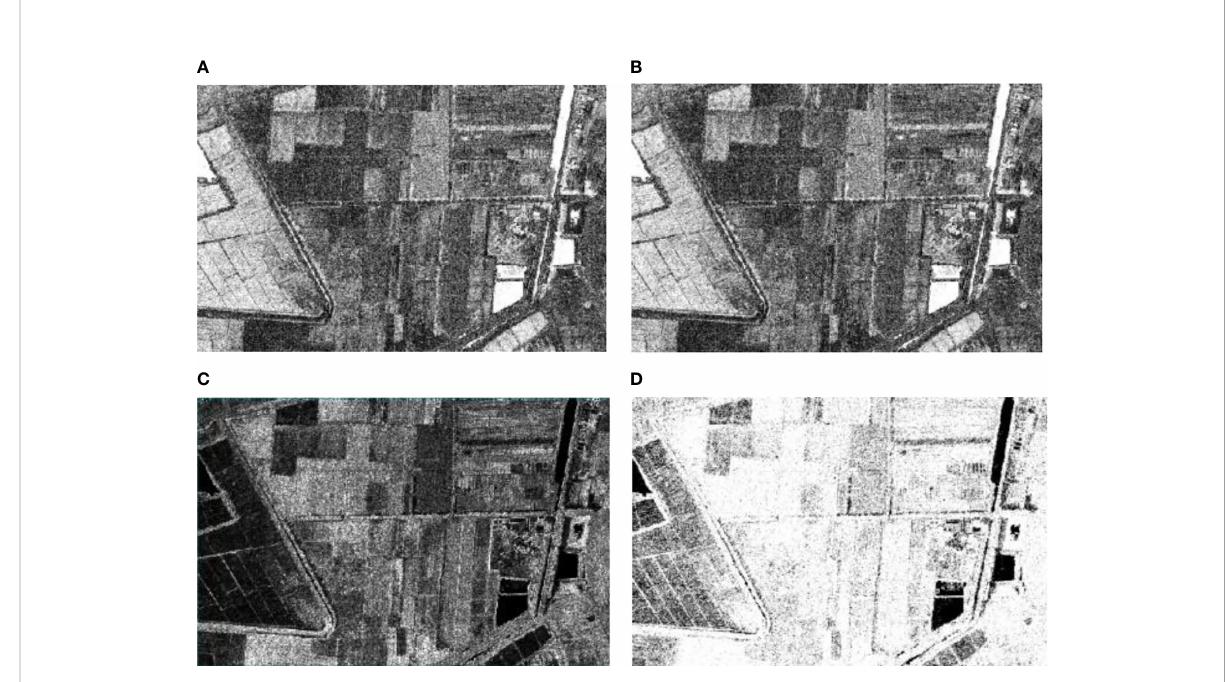
FIGURE 6 GLCM for Homogeneity, Mean, Dissimilarity and Entropy: (A) Homogeneity; (B) Mean; (C) Dissimilarity; (D)